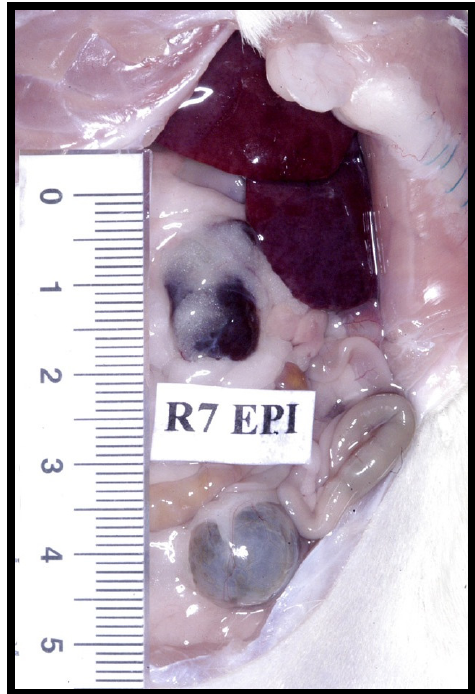
FIGURE 3 - The group II graft, emphasizing its im-